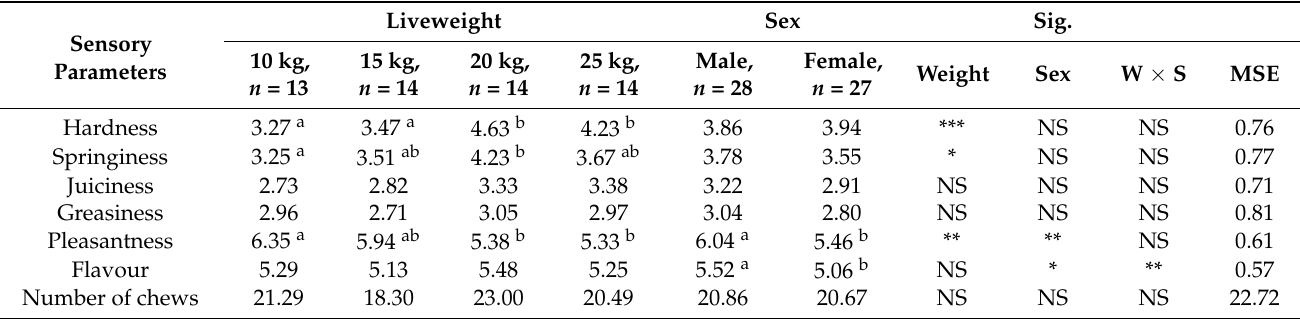
Sig. = Level of significance; *** ( p ≤ 0.001); ** ( p ≤ 0.01); * ( p ≤ 0.05); NS: non-significant. MSE = mean square error. M: male; F: female. W × S: Weight × Sex interaction. Means in the same row with different letters are significantly different ( p ≤